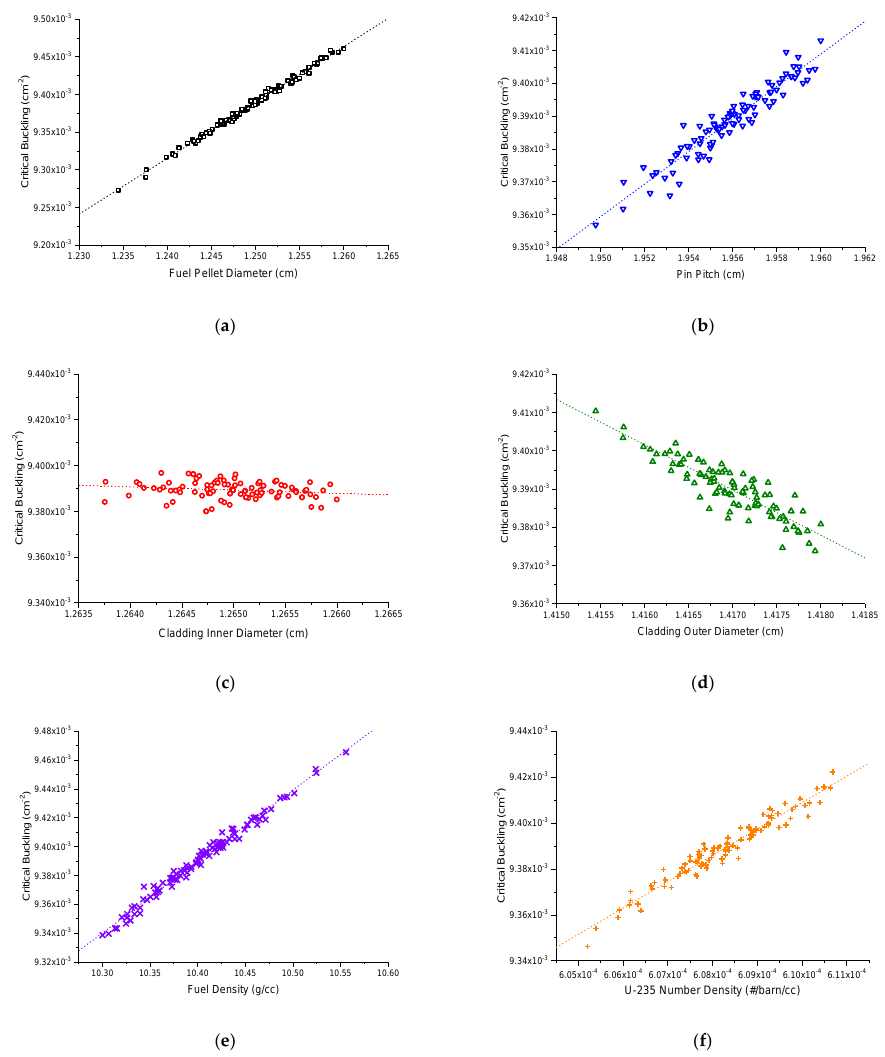
Figure 6. Distribution of critical buckling by ( a ) sampled fuel pellet diameters; ( b ) sampled pin pitches; ( c ) sampled cladding inner diameters; ( d ) sampled cladding outer diameters; ( e ) sampled fuel mass densities; ( f ) sampled 235 U number densities.